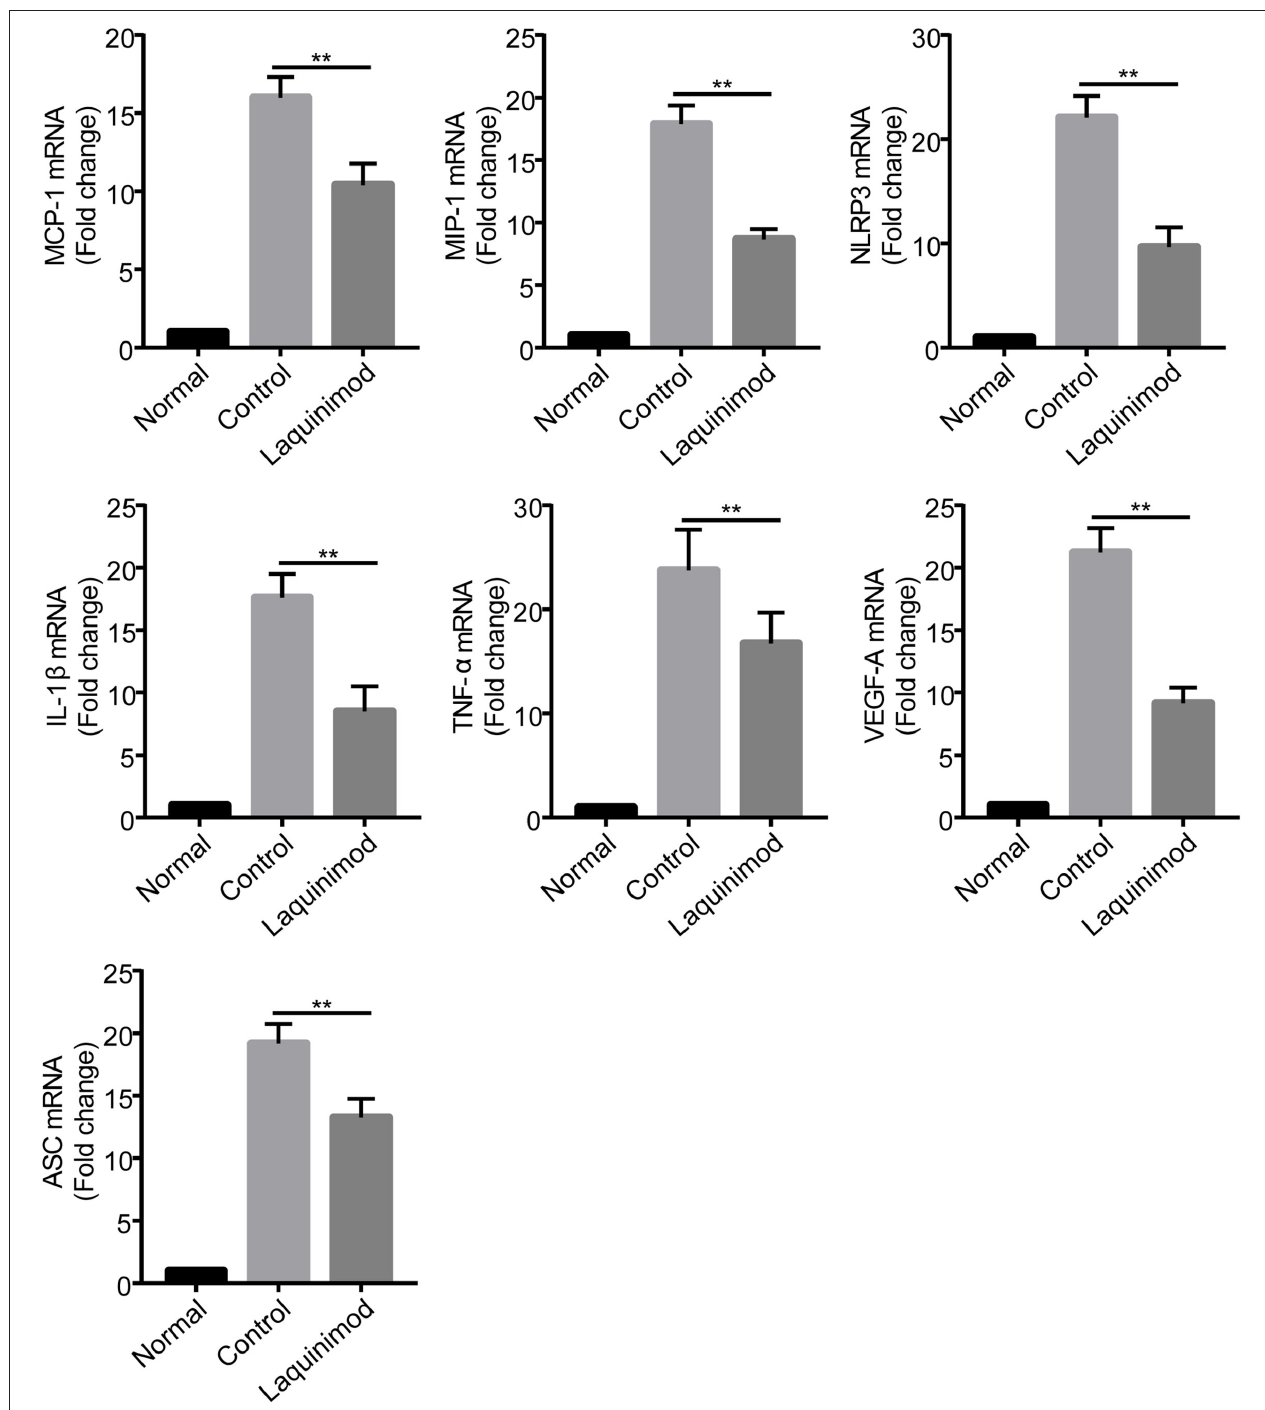
FIGURE 3 | Inhibition of chemotactic factor, inflammasome, and pro-inflammatory factor expression by laquinimod in injured corneas. Five microliters of 0.25 mg/mL laquinimod or 5 µ L of PBS was topically applied to alkali-injured corneas twice a day. The mRNA expression of chemokines (MCP-1 and MIP-1), pro-inflammatory cytokines (IL-1 β and TNF- α ), VEGF-A, NLRP3, and ASC in wound sites 3 days after injury was determined by quantitative RT-PCR. The results are expressed as the mean ± S.E.M. of the fold increase over the control ( n = 5). PBS as control, ** p < 0.01, laquinimod vs. control.